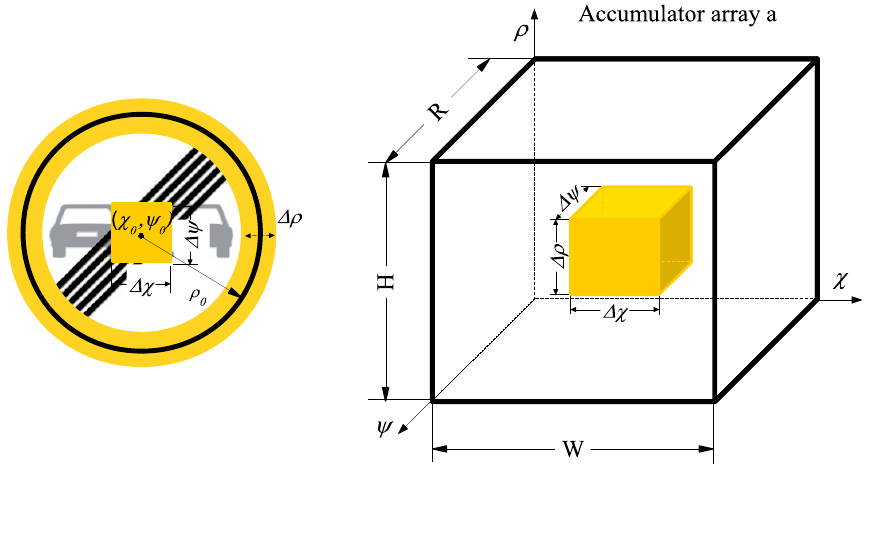
Figure 4. Constrained Hough transform applied to detect circular